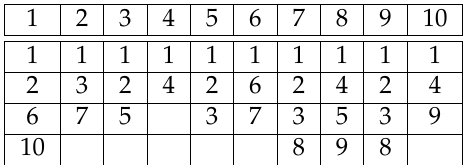
Figure 10. An example of optimal circular scheduling for N = C = 10. B ∗ =